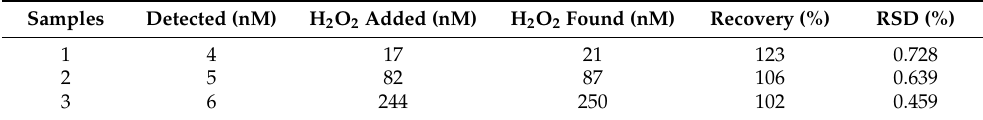
Table 2. Sensing of hydrogen peroxide in urine samples of cancer patients ( n = 3). Samples